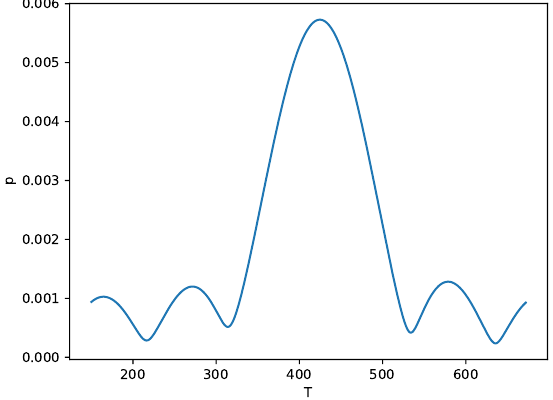
Figure 9. Probability for 50k